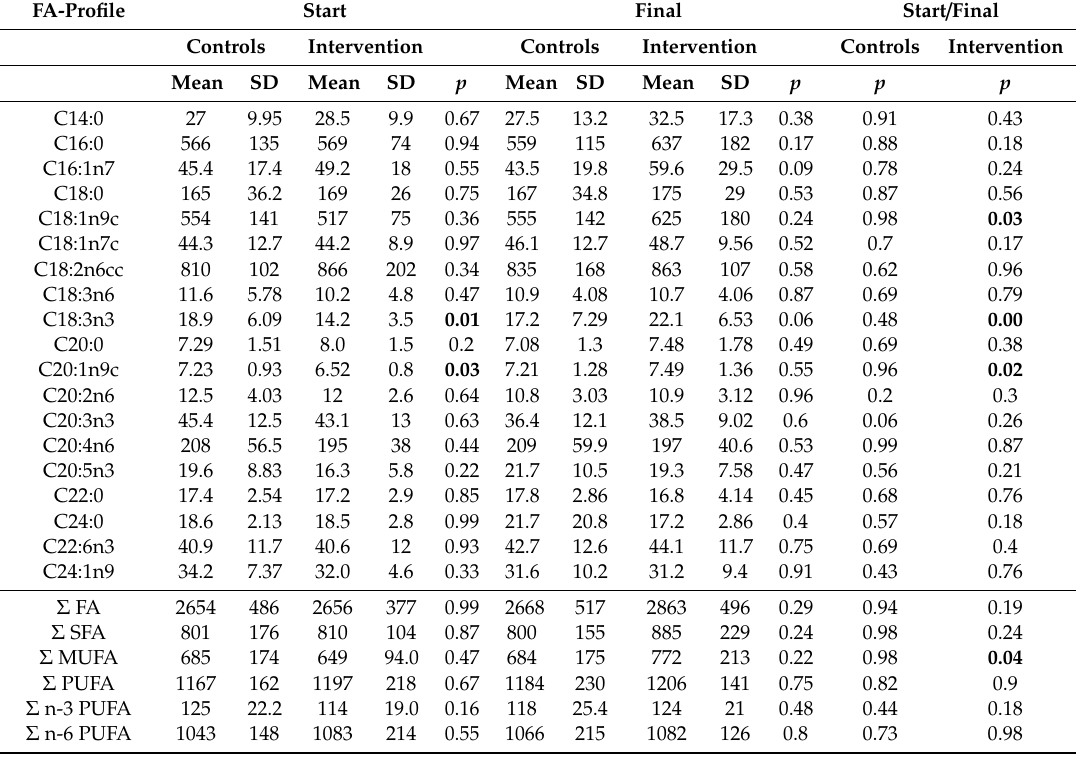
Table 5. Plasma FA profile during intervention in µ g /